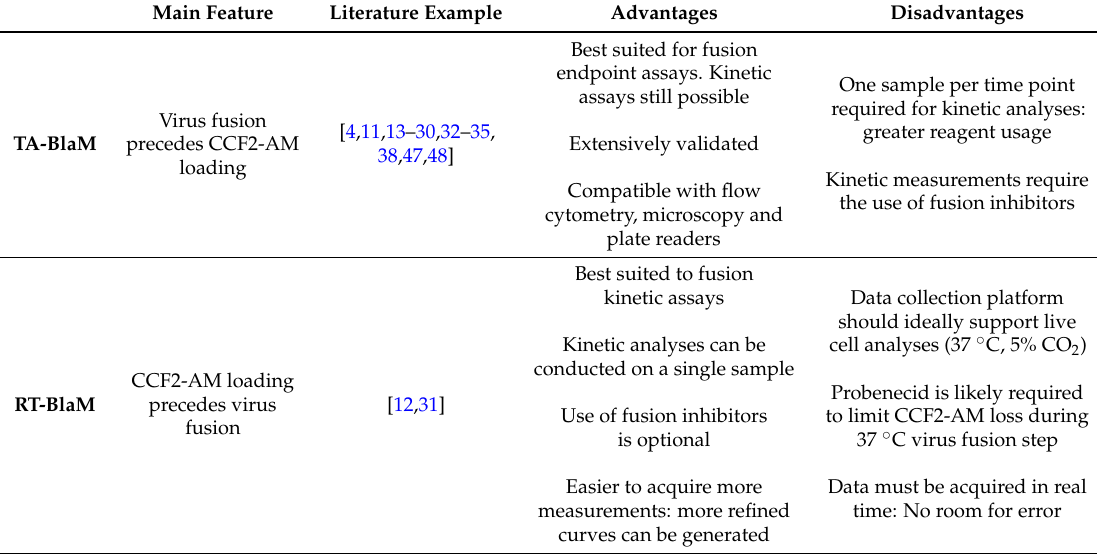
Table 2. A comparison of the features, advantages and disadvantages associated with the TA- and RT-BlaM